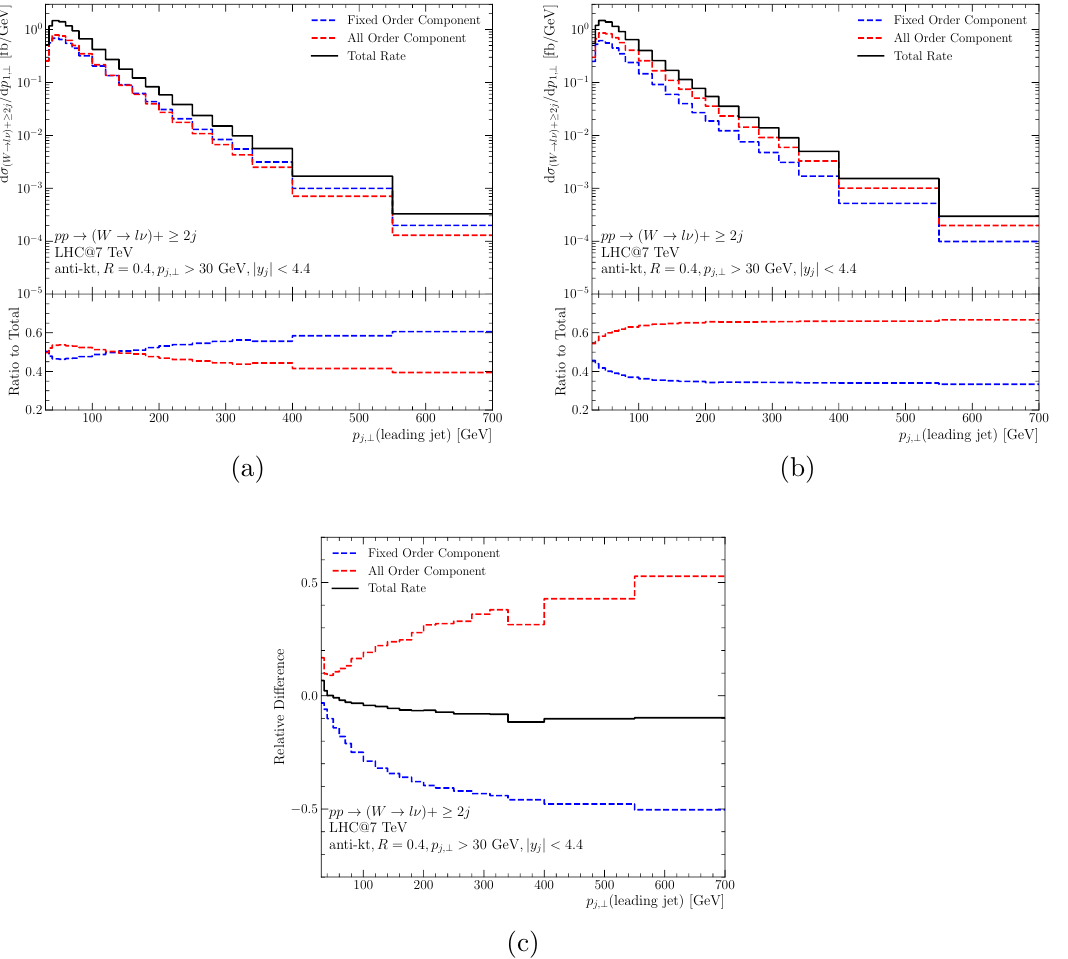
Figure 23. The differential distribution (black, solid) in the transverse momentum of the leading jet in pp → ( W → ‘ν ) ≥ 2 j , without and with resummation applied to NLL states. The panels and lines are as in figure